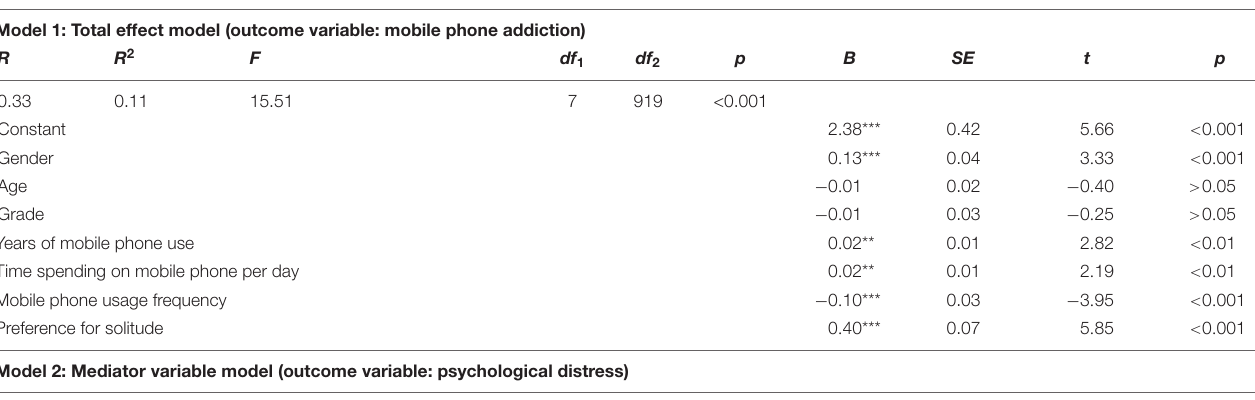
TABLE 3 | Regression results for the conditional indirect effects (moderated mediation).